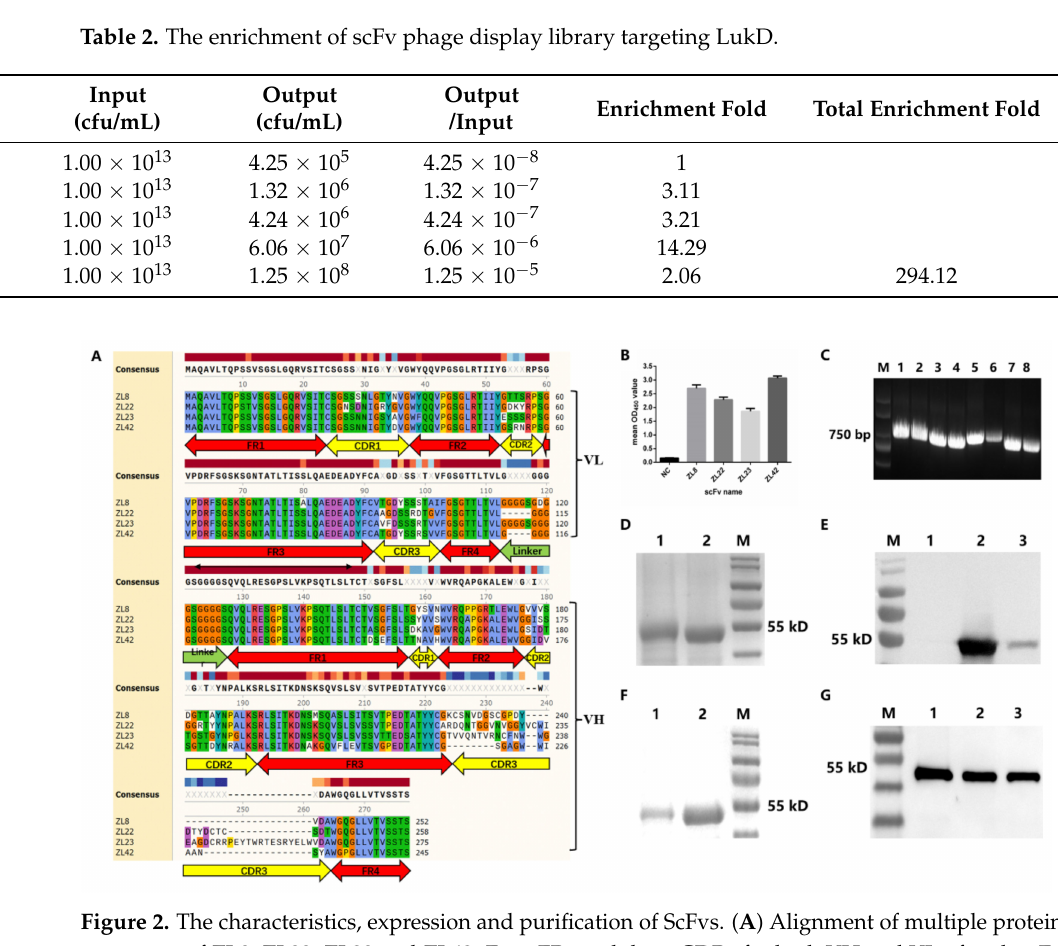
Figure 2. The characteristics, expression and purification of ScFvs. ( A ) Alignment of multiple protein sequences of ZL8, ZL22, ZL23 and ZL42. Four FRs and three CDRs for both VH and VL of each scFv are illustrated above. The same color regions represent the identity of amino acids, while the blank regions represent amino acid differences of the four scFvs. ( B ) The value of OD 450 of the four clones. Lane M, 2000-bp DNA ladder. ( C ) PCR products of scFvs amplificated from positive scFv phage clones. Lane M, 2000-bp DNA ladder; lanes 1–2, scFv PCR product of ZL23; lanes 3–4, scFv PCR product of ZL8; lanes 5–6, scFv PCR product of ZL22; lanes 7–8, scFv PCR product of ZL42. ( D , F ) The SDS–PAGE analysis. Lane M of ( D , F ), protein molecular weight marker; lanes 1–2 of ( D ), the purified proteins of ZL23 and ZL22, respectively. Lanes 1–2 of ( F ), the purified proteins of ZL8 and ZL42, respectively. ( E , G ) The western blotting assay. Lane M of ( E , G ), protein molecular weight marker; lane 1 of ( E ), without IPTG induction; lanes 2–3 of ( E ), the purified protein of ZL23; lanes 1–3 of ( G ), the purified protein of ZL8, ZL22 and ZL42,